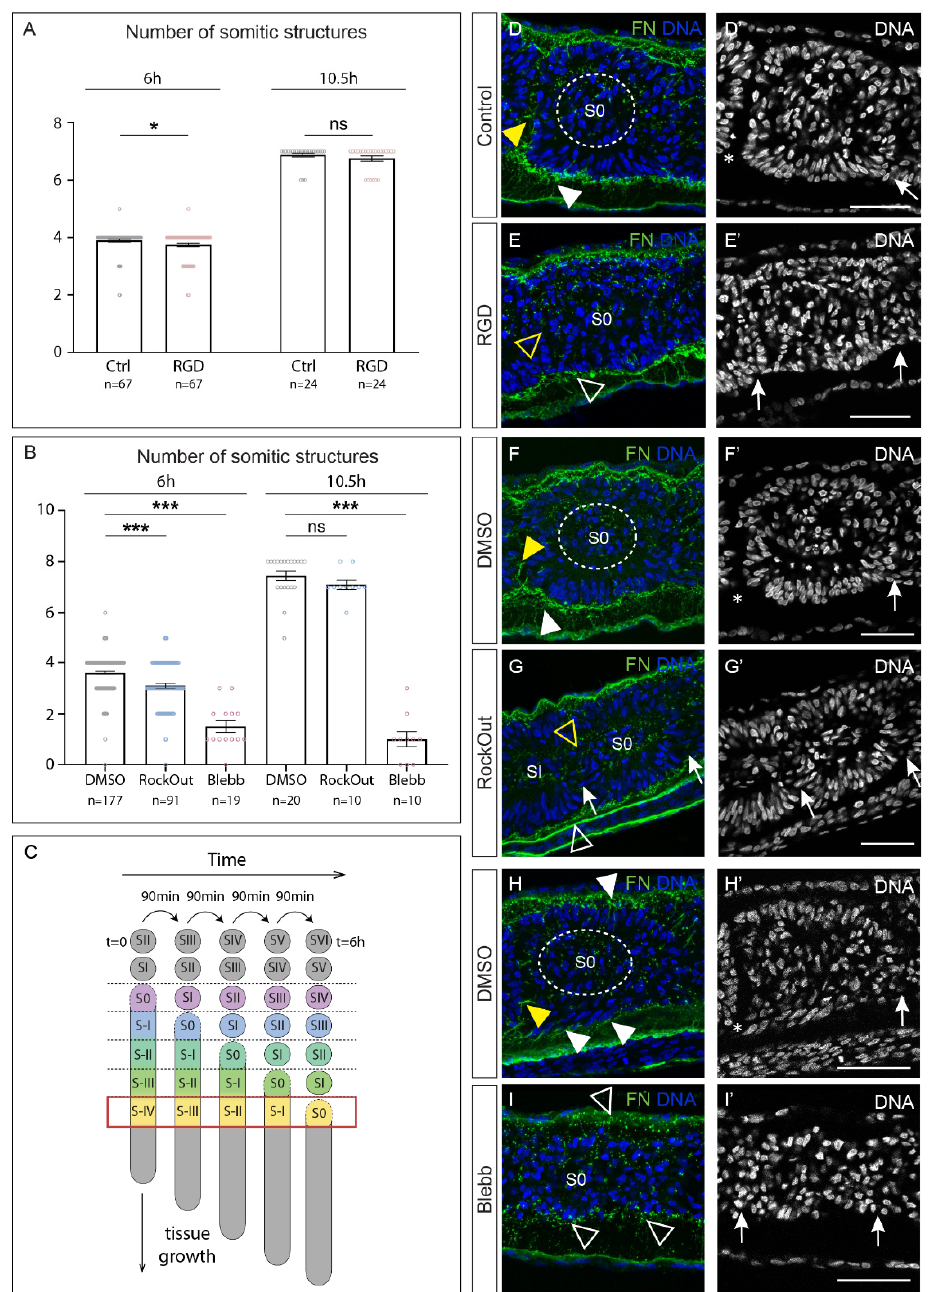
Figure 3. Somite morphology and cleft formation are affected by RGD, RockOut and Blebbistatin. ( A ) Number of somitic structures formed after 6 or 10.5 h in culture in control (mean = 3.9; SEM = 0.04; mean = 6.9; SEM = 0.09) and RGD-treated (mean = 3.7; SEM = 0.07; mean = 6.8; SEM = 0.09) explants. ( B ) Number of somite structures formed in explants cultured for 6 or 10.5 h with DMSO (mean = 3.6; SEM = 0.05; mean = 7.5; SEM = 0.19), RockOut (mean = 3.1; SEM = 0.09; mean = 7.1; SEM = 0.18) or Blebbistatin (mean = 1.5; SEM = 0.23; mean = 1.0; SEM = 0.30). ( C ) Strategy of analysis: Here we analysed the S0 region after 6 h in culture, which corresponds to S-IV when the treatments began (red box). ( D – I’ ) Sagittal views of explant pairs in experiments aimed at testing the effect of RGD ( D – E’ ), RockOut ( F – G’ ) and Blebbistatin ( H – I’ ) on somite formation. Immunostaining for fibronectin and staining for DNA. Rostral is to the left and dorsal on top. In control explants, the fibronectin